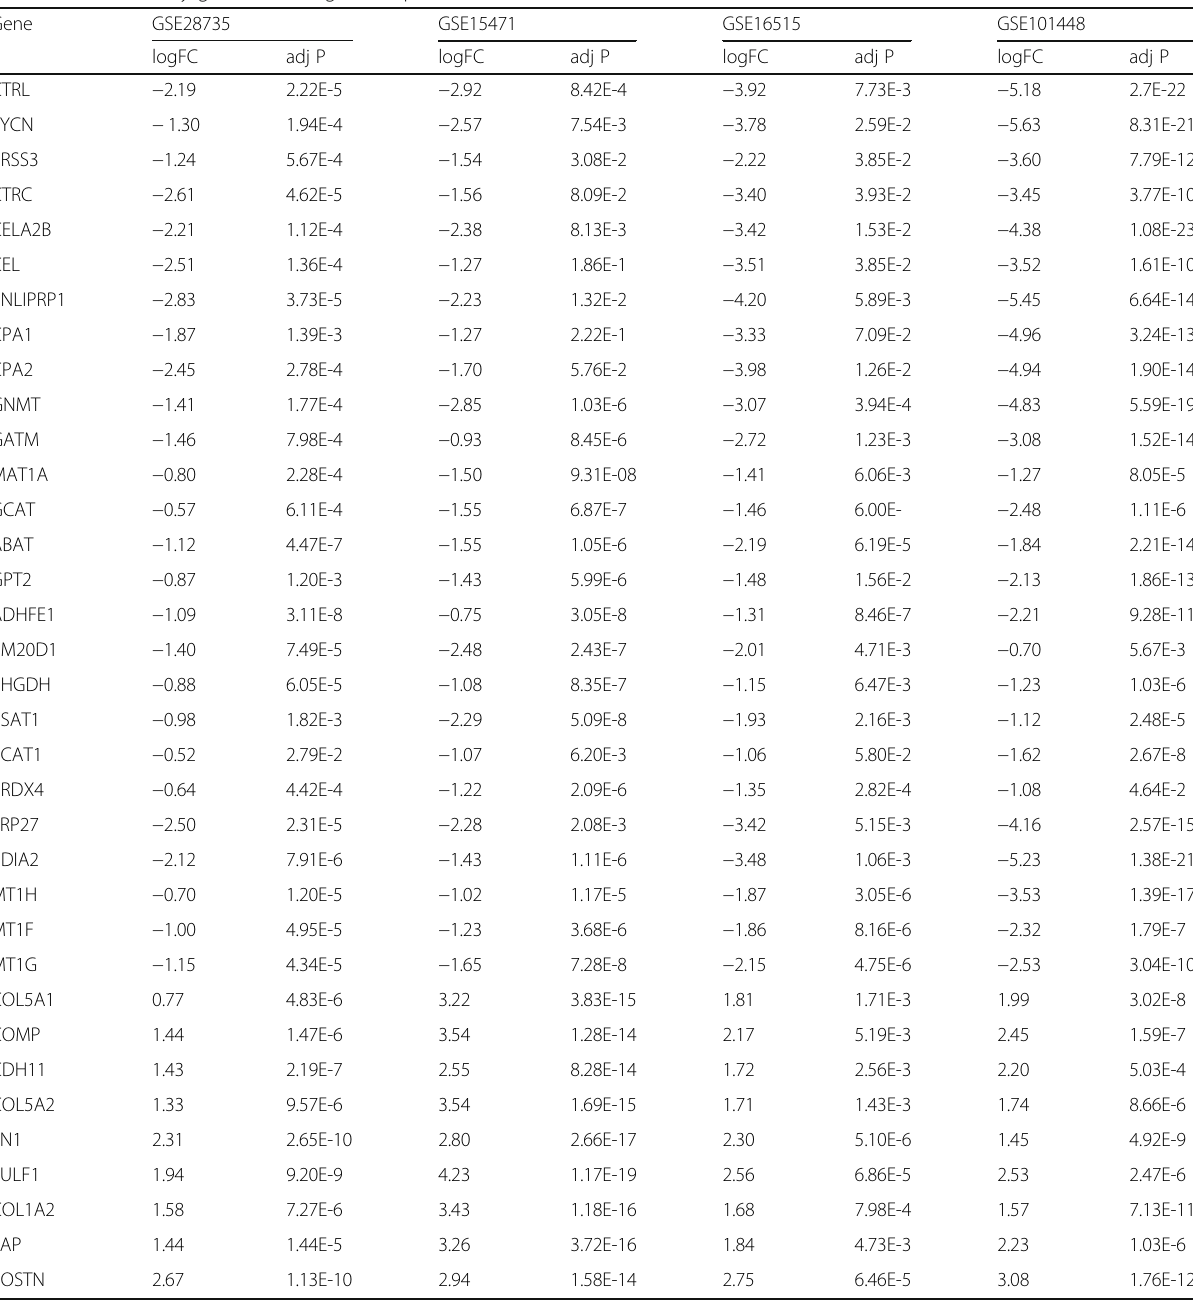
Table 2 List of 35 key genes in four gene